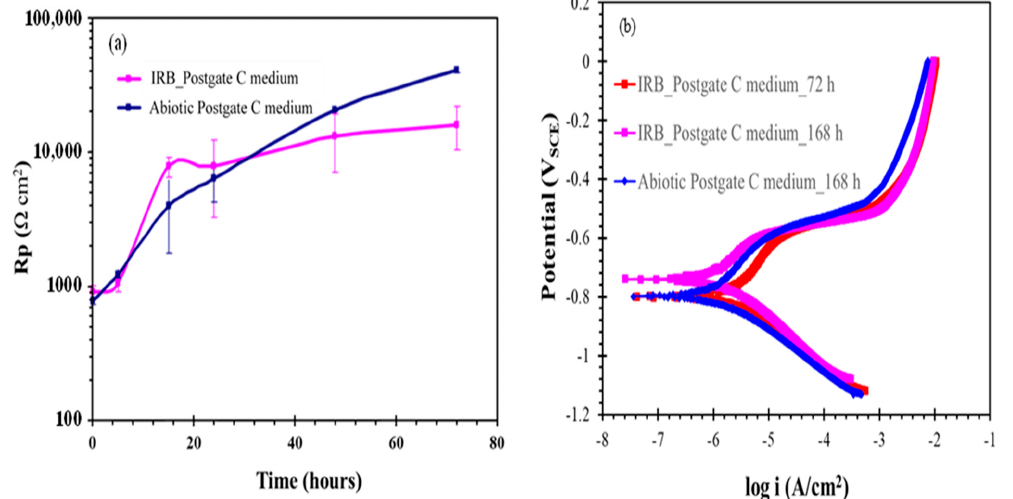
Figure 6. ( a ) Polarization resistance ( a ) of carbon steel exposed to a pure IRB culture and abiotic conditions in Postgate C medium, and ( b ) a potentiodynamic polarization and ( b ) scan of carbon steel after 72 h exposure with and without IRB.